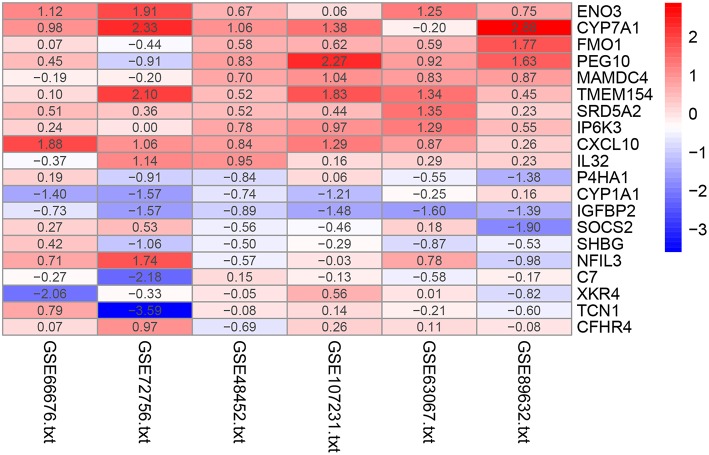
Heatmap of the top 10 up- and down-regulated genes in the RRA analysis. Red represents high expression of genes in patients with NAFLD, while blue represents low expression of genes in patients with NAFLD.